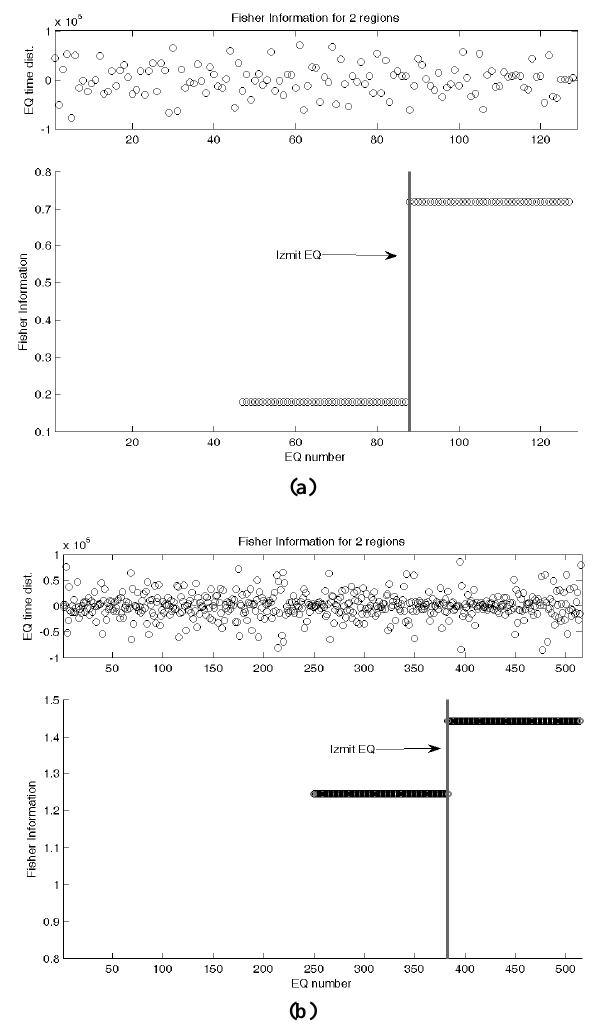
Fig. 8. Fisher information of the seismicity for the EQ events oc- curring during the time period 20 May 1999 to 7 September 1999, 11:56:50.5 (UT), i.e. up to the time of the Athens EQ occurrence: (a) near Athens, i.e. within a 200km radius from the Athens epicen- tre, and (b) away from Athens, i.e. in the rest of Greece excluding the area confined by the 200km radius circle around the Athens EQ epicentre. The analyzed time-series is given on top of the resulted Fisher information temporal evolution, time aligned for direct ref- erence. The vertical grey line indicates the time of the Izmit EQ